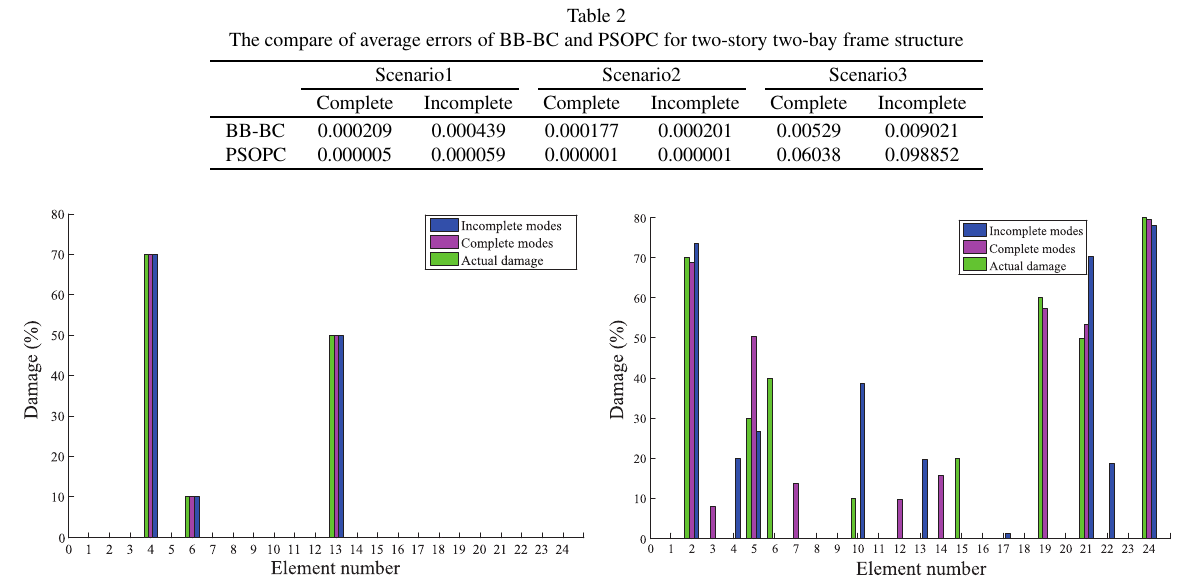
Fig. 16. Damage detection via PSOPC for a large number of damage locations of frame (Scenario 3).